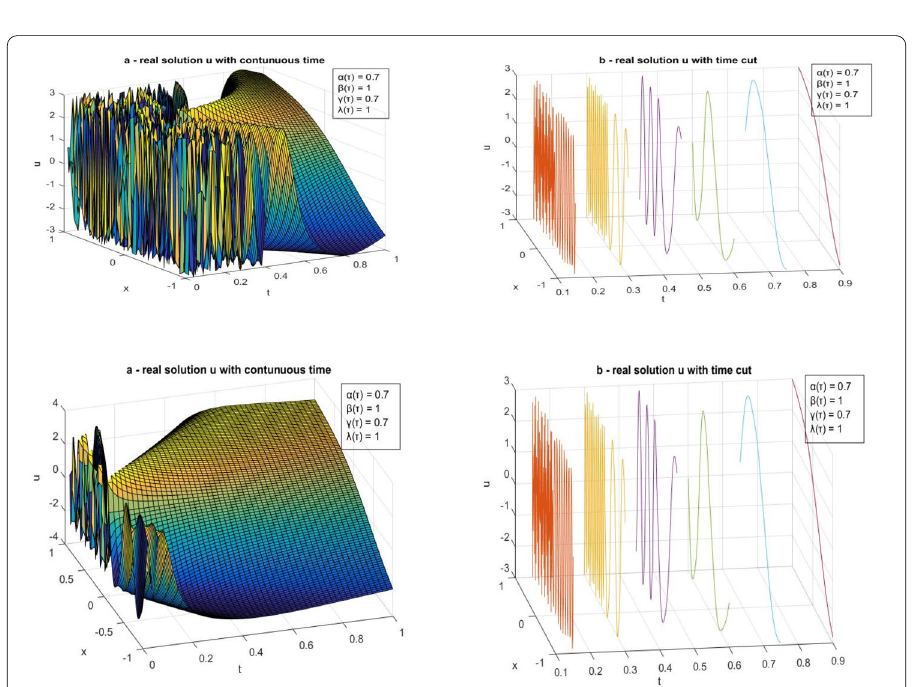
Figure 7 The graphs the solution in Example 3 with different values for α ( τ ), β ( τ ), γ ( τ ), and λ ( τ